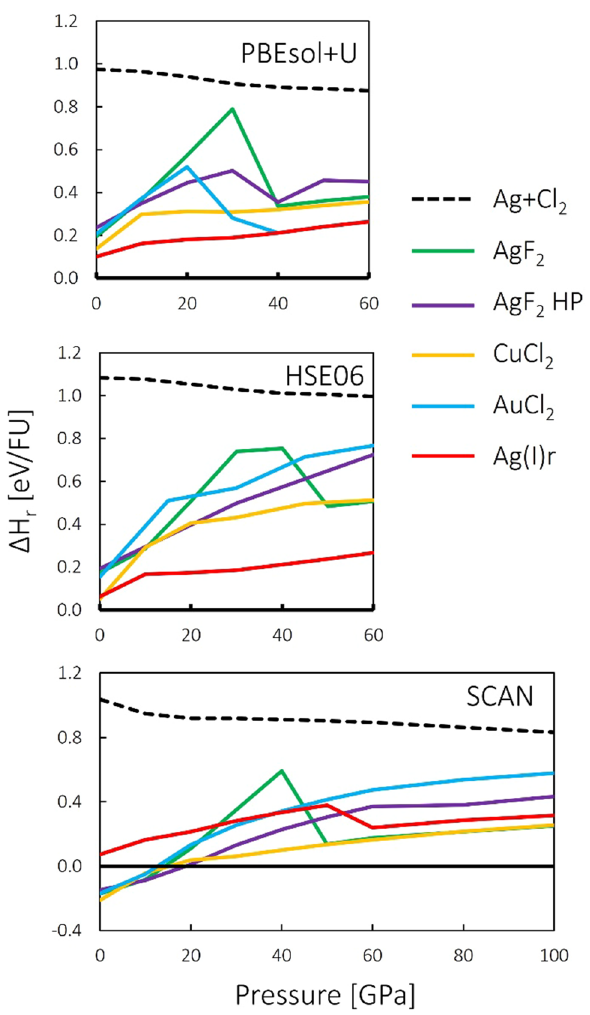
Figure 2. Stability of selected studied polymorphs of AgCl 2 , plotted as enthalpy per formula unit relative to AgCl + ½Cl 2 (ΔH r ). Top panel—PBEsol + U (GGA functional), middle panel—HSE06 (hybrid functional), bottom panel—SCAN (meta-GGA functional). FU formula